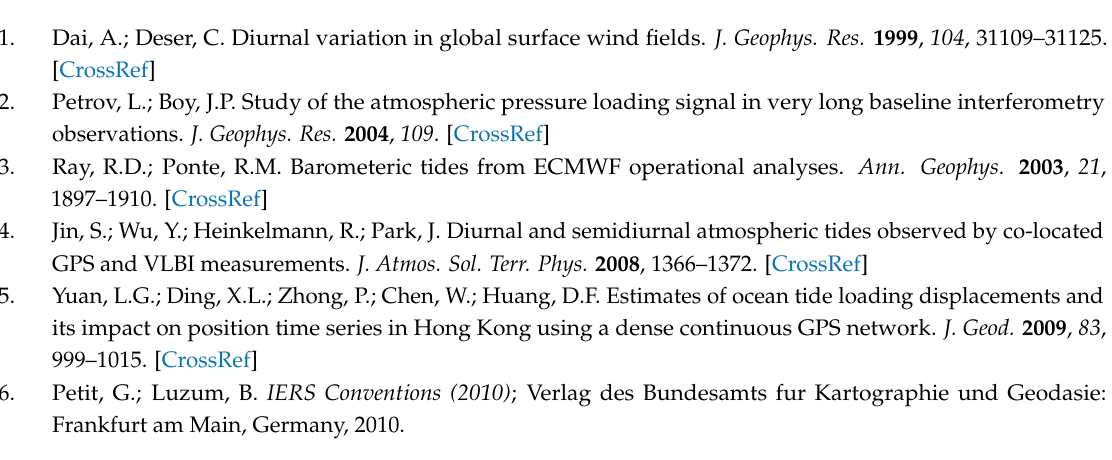
s1. Figure S1: Annual amplitudes and phases of the S1/S2 induced surface displacement, Table S1: Average uncertainty of GPS time series for each station and its time span, Table S2: WRMS for the GPS time series before (left) and after S1/S2 correction